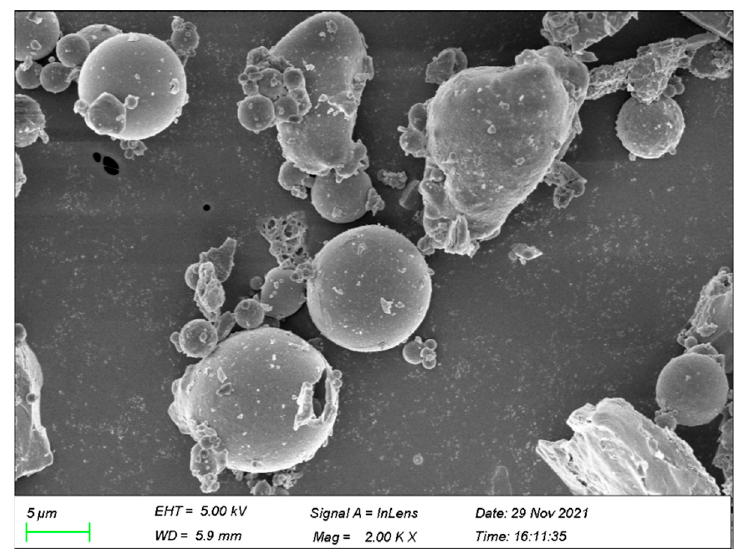
Table 3. Physical parameters of nano-SiO 2 [39].